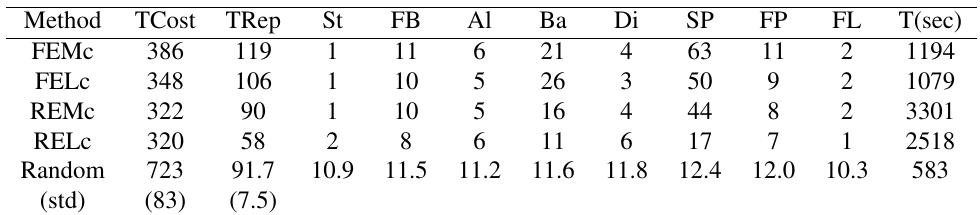
Table 7. DAP-TC results when threshold is 0.50.